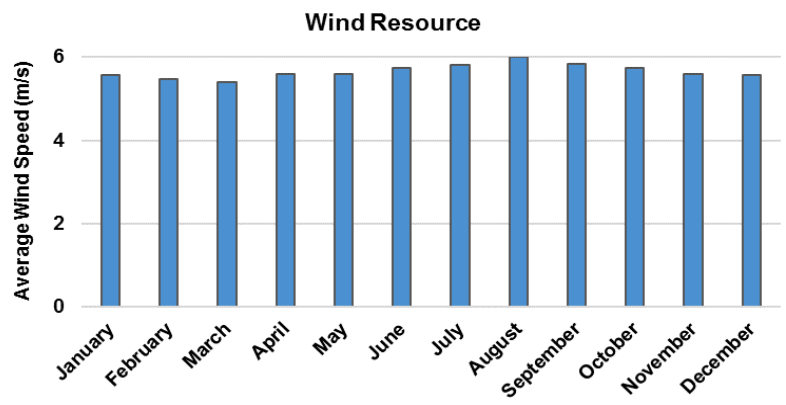
Figure 5. Monthly average wind speed in South Africa.